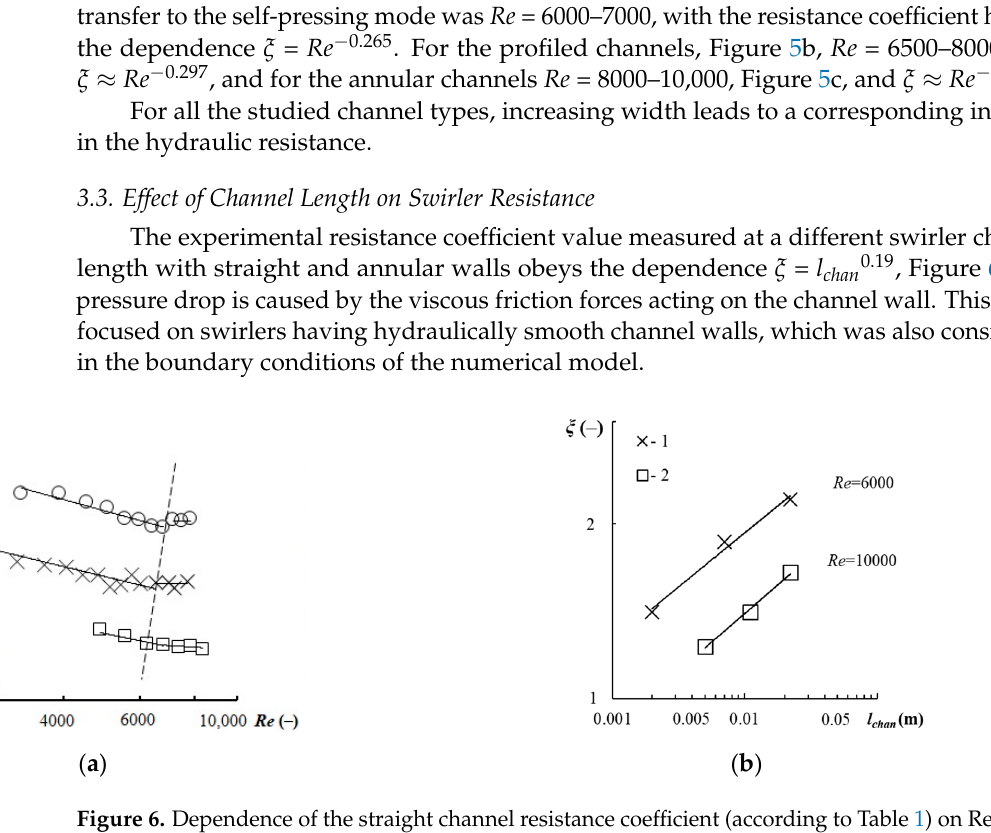
Figure 5. Dependence of the resistance coefficient on the Reynolds number for swirlers with straight ( a ), profiled ( b ), and annular ( c ) channel walls. Experimental points (according to Table 1): ( a ) 1— No. 2 at l w = 0.004 (m); 2—No. 5 at l w = 0.012 (m); 3—No. 6 at l w = 0.022 (m); 4—No. 9; 5—No. 1;